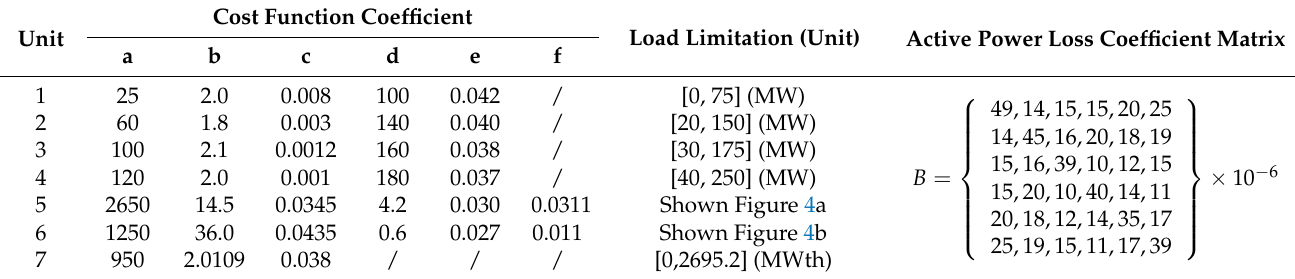
Table 3. Characteristic parameters of test system II